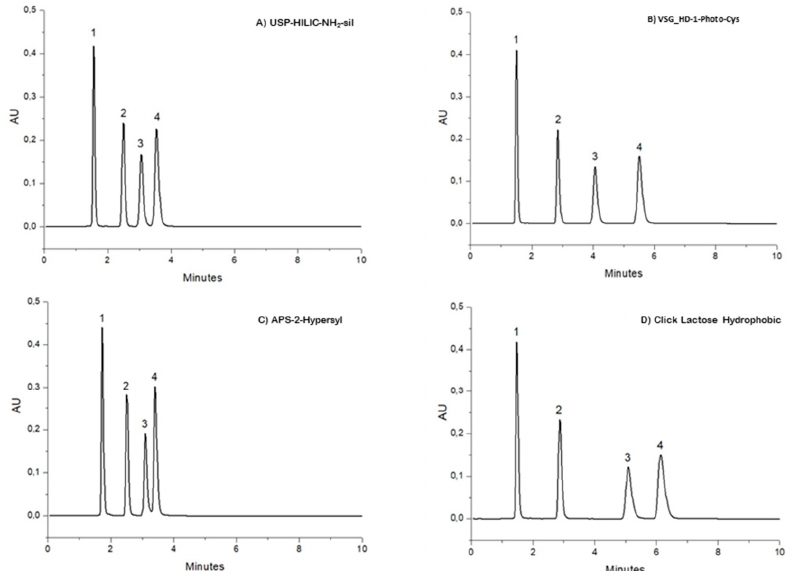
Figure 1. Chromatograms (HILIC test) carried out by eluting a mixture consisting of ( 1 ) naphthalene, ( 2 ) uracil, ( 3 ) adenosine and ( 4 ) cytosine (as in elution order) performed on the ( A ) USP-HILIC-NH2- sil, ( B ) VSG_HD-1-Photo-Cys, ( C ) APS-2-Hypersyl and ( D ) Click Lactose Hydrophobic stationary phases. Mobile phase: 80/20 ACN/H 2 O (% v / v ), flow rates: ( B ) 1 mL/min, and ( A , C , D ) 0.8 mL/min. Column temperature: 25 °C; injection volume: 5 µL, Chromatograms were recorded at 254 nm.